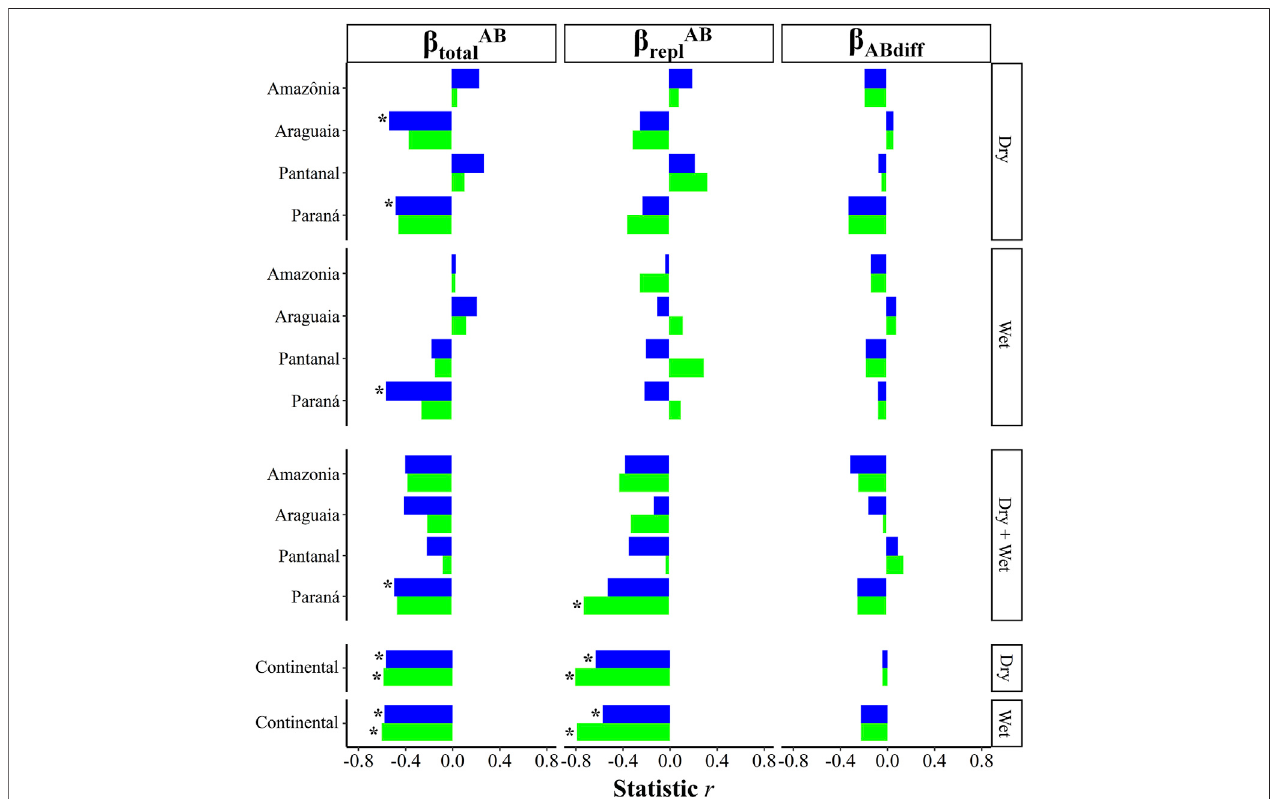
FIGURE 7 | Mantel test results showing the r -statistic between the observed congruence and the functional distances between biological groups for abundance data. Blue = Taxonomic facet; Green = Functional facet. * p < 0.05.